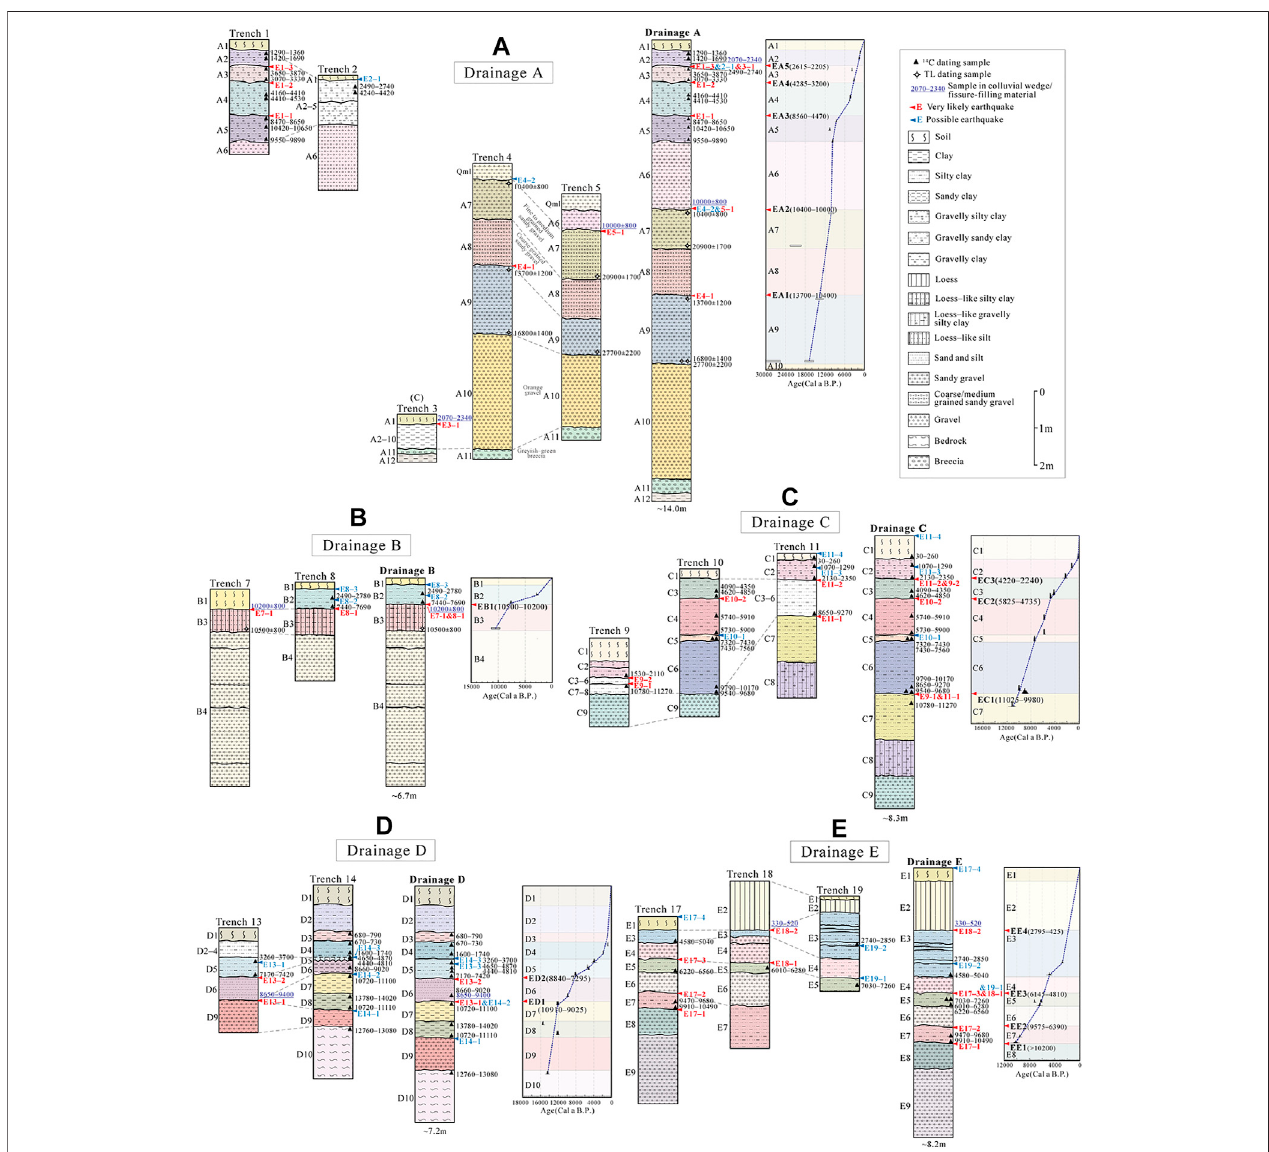
FIGURE 2 | Single-trench stratigraphic sequences, composite stratigraphic sequences of multiple trenches, age framework, and inferred ages of paleoearthquakes in (A) Drainage A, (B) Drainage B, (C) Drainage C, (D) Drainage D, and (E) Drainage E. Dating results and event indicators are shown in the single- trench sequences of each trench. The dashed lines indicate the proposed correlation among these trenches. In composite stratigraphic sequences, we label units (A) from A1 to A12, (B) from B1 to B4, (C) from C1 to C9, (D) from D1 to D10, and (E) from E1 to E9, from top to bottom.